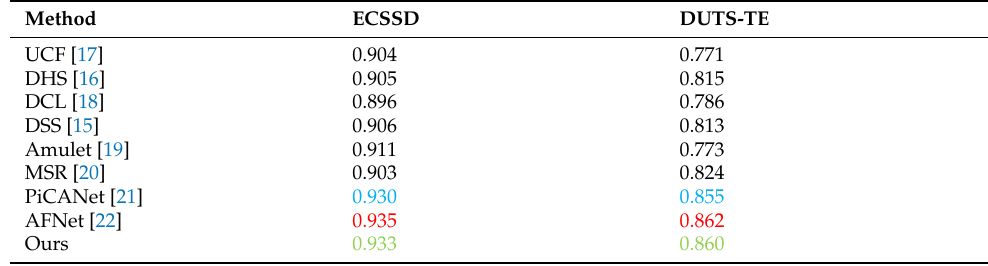
Table 2. Quantitative comparisons with different methods on 2 datasets with F-measure score. The best three results are shown in red, green and